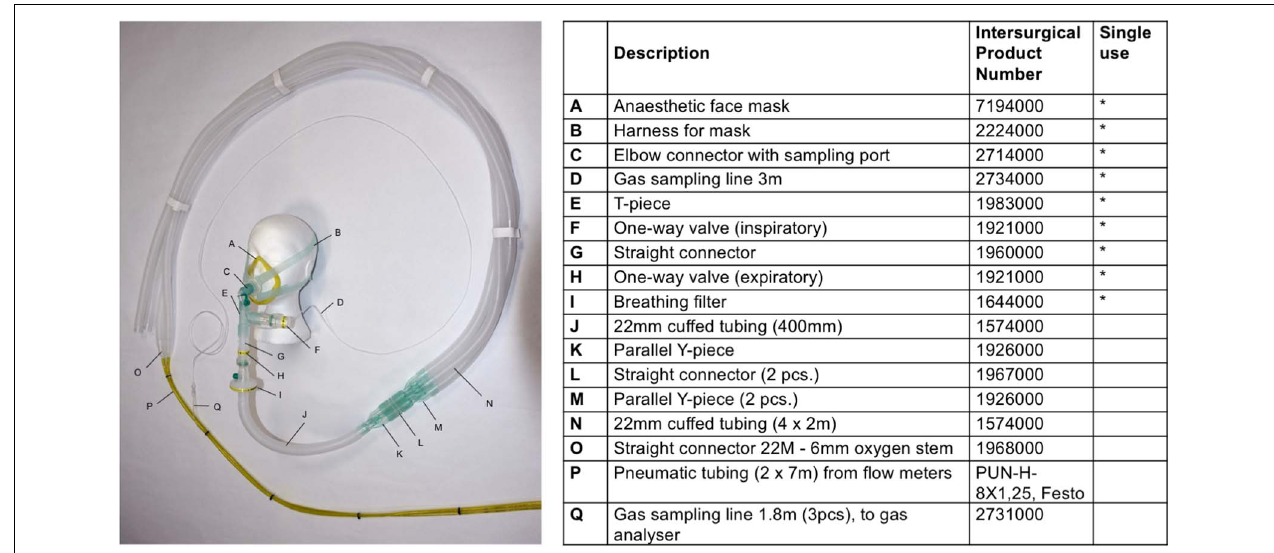
FIGURE 2 | Breathing circuit for the CO 2 -CVR respiratory paradigm, and the corresponding product identification numbers from Intersurgical Ltd., Wokingham, United